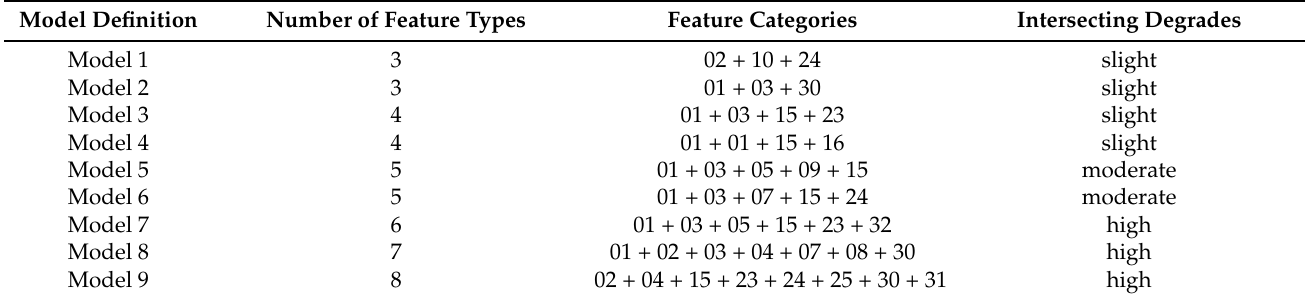
Table 1. The detailed description of the multi-machining feature